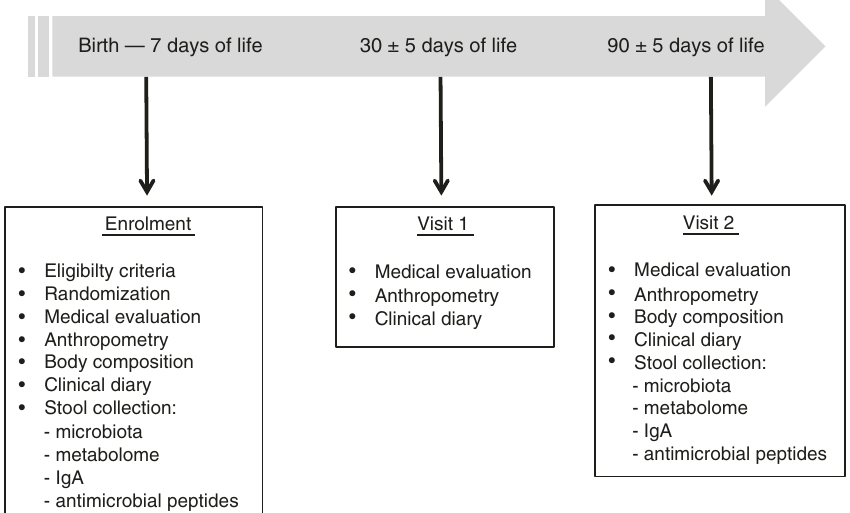
Fig. 1 Study procedures. Procedures related to collection of biological samples, medical evaluation and anthropometric measurements are shown in a